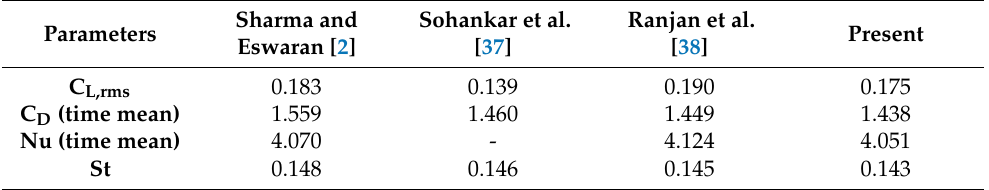
Table 1. Comparison of C L , r.m.s , C D (time mean), Nu (time mean) and St for square cylinder at Ri = 0, Re = 100, α = 0 ◦ and Pr =